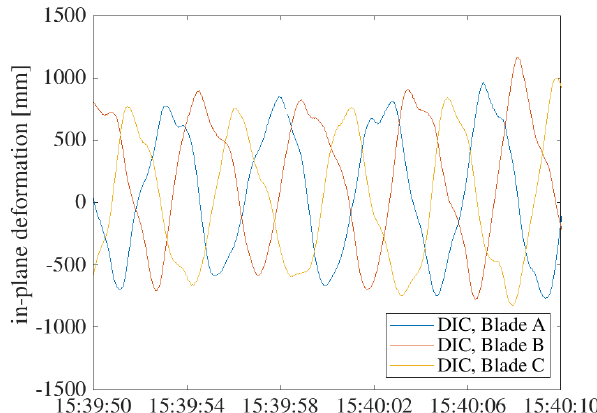
Figure 17. IP DIC signal of all blades – close-up.